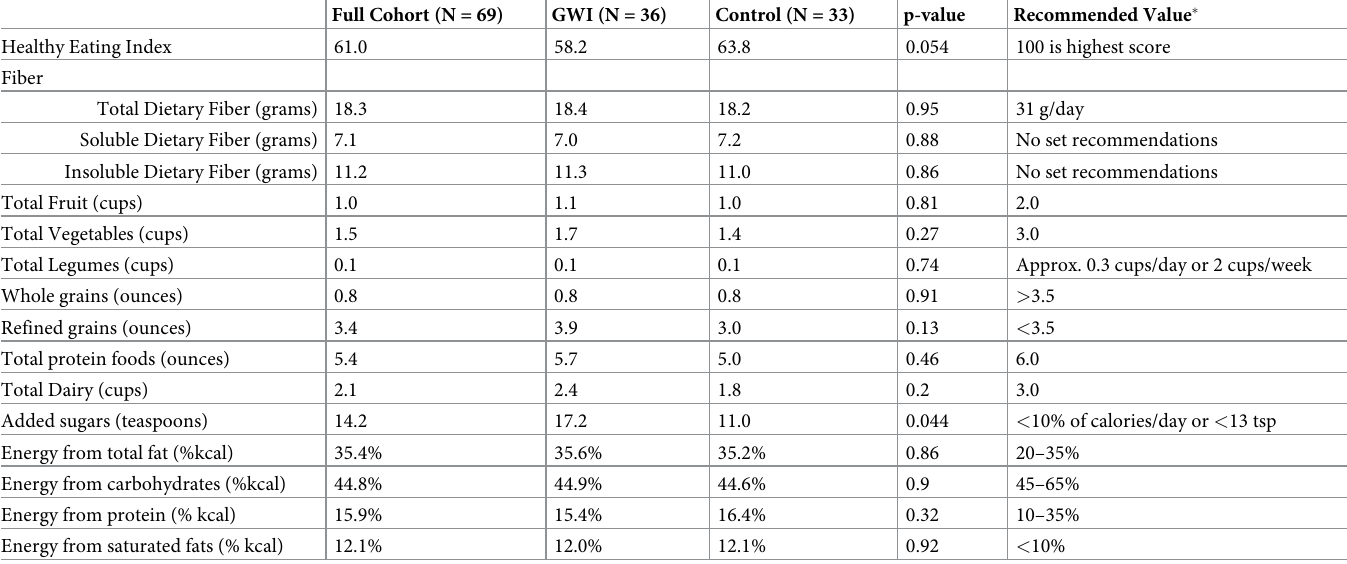
Table 5. Mean dietary data by